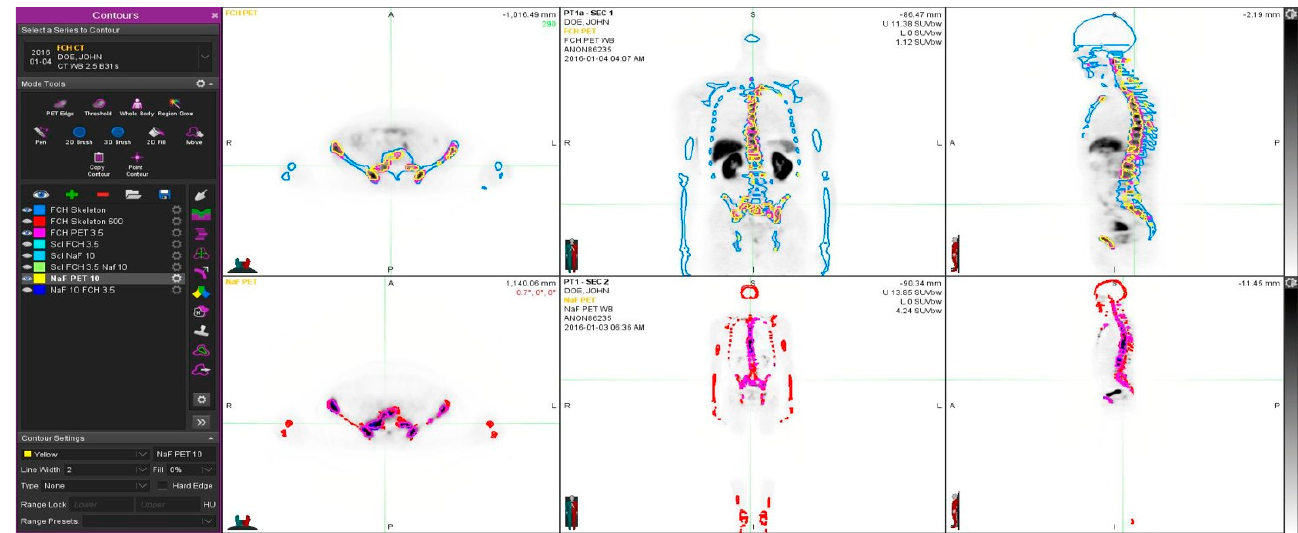
Figure 1. Example of a patient study (pt 11, Table 1). This 67-year old patient had an aggressive prostate cancer, T4N1M1 when initially diagnosed with Gleason score 9. S-PSA was 40. The upper row shows FCH PET study one transaxial, coronal and sagittal section. The lower row illustrates the same sections in the NaF PET study. Here, normal skeleton (HU > 150 as measured from simultaneous CT) is shown in red on NaF PET (lower row) and blue on FCH PET (upper row). Pathologic NaF (SUV > 10) is shown in yellow on FCH PET (upper row) and pathologic FCH (SUV > 3.5) in purple on NaF PET (lower row). This demonstrates clearly that volume regions differ significantly from each other, and PET tracers show different distributions, i.e., NaF is targeting cortical bone and FCH bone marrow.